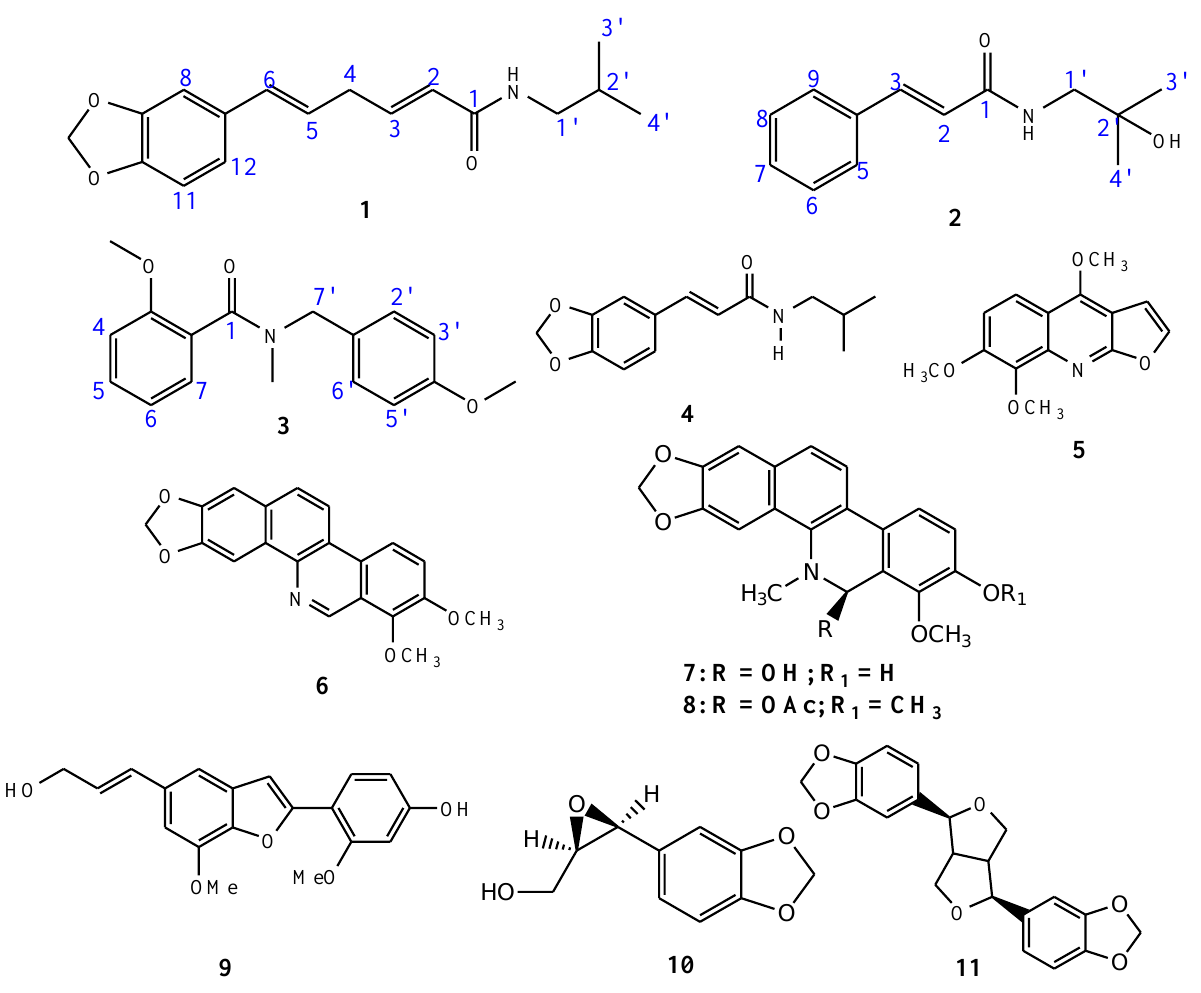
Figure 1. Identified compounds from Z. chalybeum ’s root b ark .